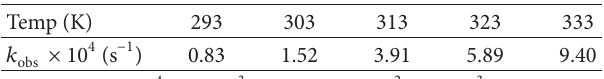
T 5: Effect of temperature on the reaction